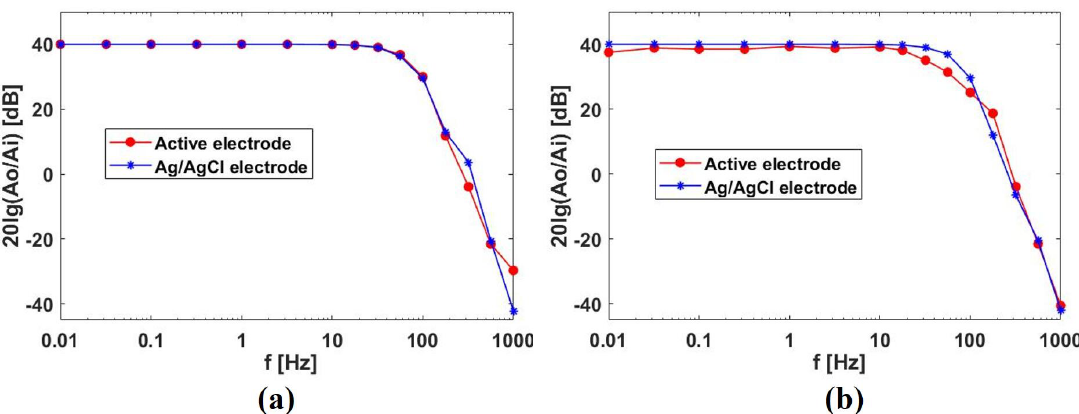
Figure 9. Amplitude-frequency response of active electrode system and passive electrode system: ( a ) electrodes of the active electrode system measure signals directly, ( b ) electrodes of the active electrode system measure signals through clothes(a simple cotton underwear about 1 mm in thickness).